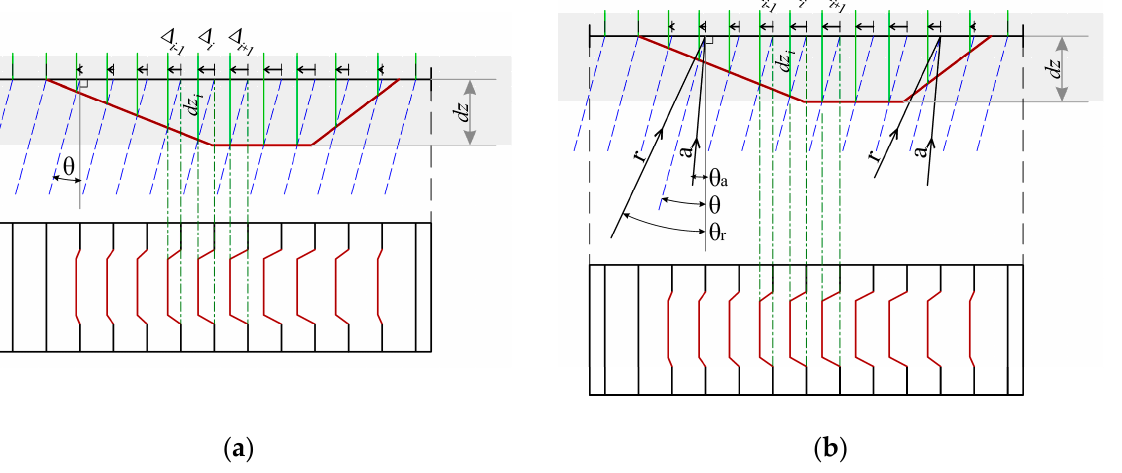
Figure 13. Projection of structured ( a ) and interference ( b ) fringes at an angle of θ onto the 3D object shaped as a prism. The shift ∆ i of fringes is proportional to the local thickness of the 3D object. a—object beam; r—reference beam; dz —object depth.